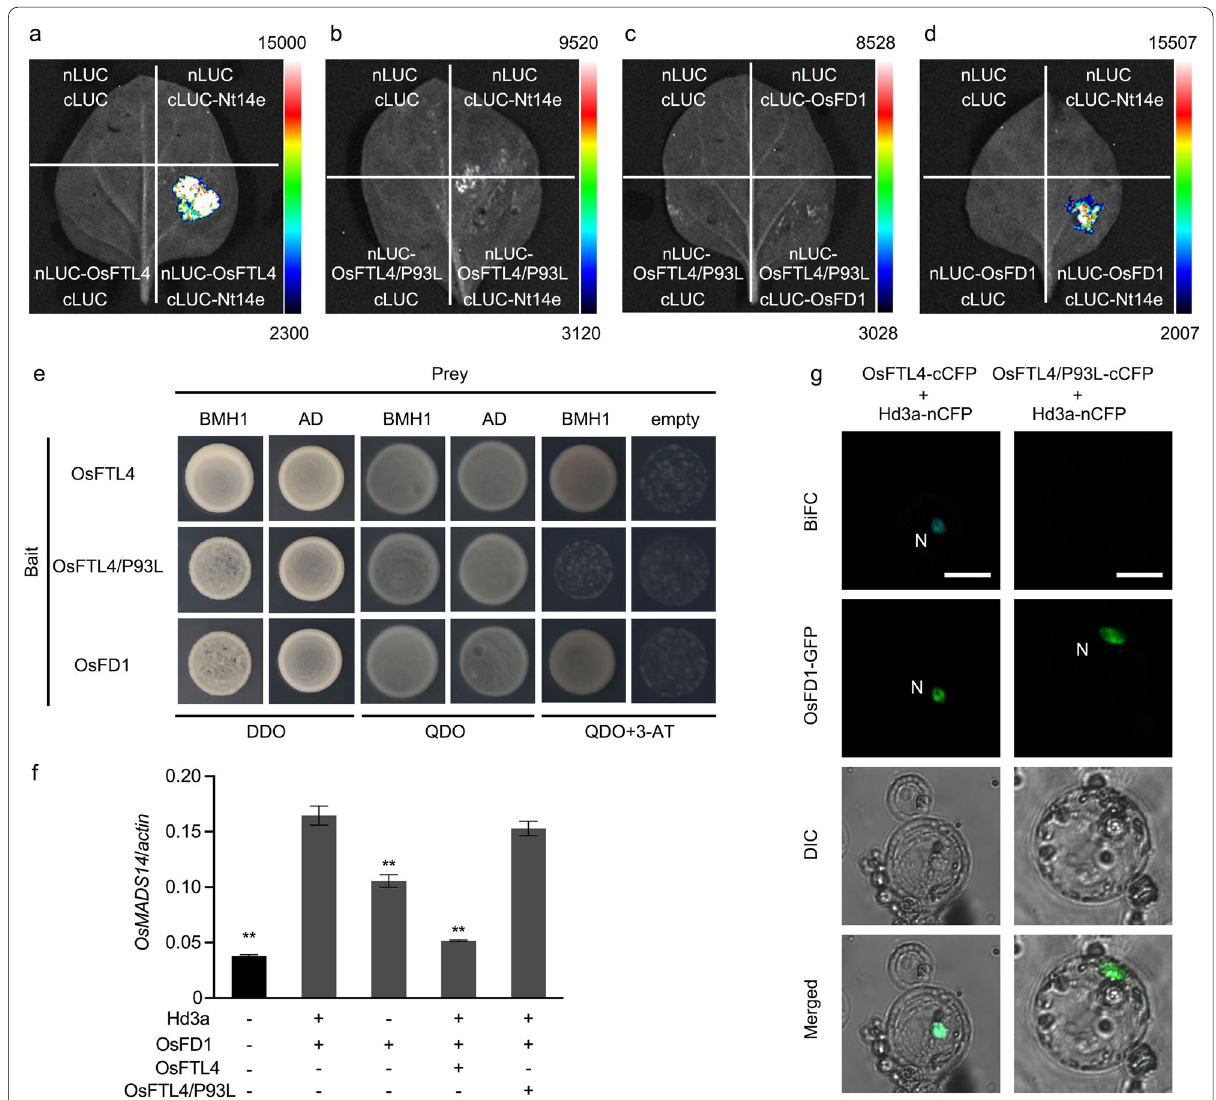
Fig. 6 OsFTL4 competes Hd3a for formation of florigen activation complex. The interaction between OsFTL4 and Nt14-3-3e a , OsFTL4/P93L and Nt14-3-3e b , OsFTL4/P93L and OsFD1 c , OsFD1 and Nt14-3-3e d were detected by using LCI assays. Nt14e: Nt14-3-3e. e The interaction between Nt14-3-3e and OsFTL4, Nt14-3-3e and OsFTL4/P93L, OsFD1 and Nt14-3-3e were tested by using Y2H assays. f Effect of OsFTL4 on OsMADS14 activation by FAC. Values are means SEM from three independent experiment. Asterisks indicate the significance of differences determined by ± Student’s t test: **, p < 0.01. g Co-localization of Hd3a and OsFTL4. BiFC assays between Hd3a and OsFTL4 (left) and between Hd3a and OsFTL4/P93L (right) were performed. N: Nucleus. Scale bar: 20 μm